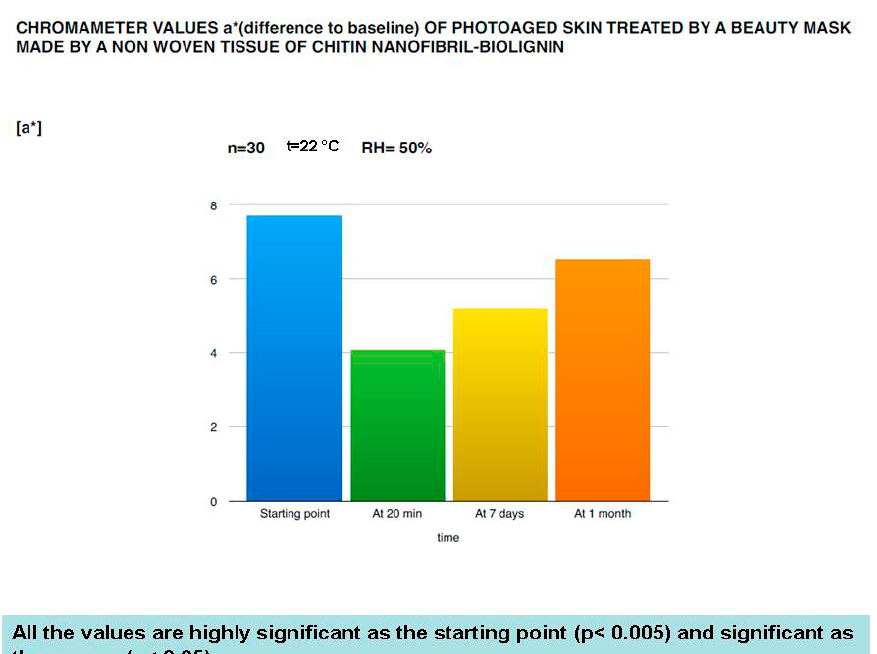
Figure 10. Effectiveness of the in-study mask on the TEWL balance of photoaged women.